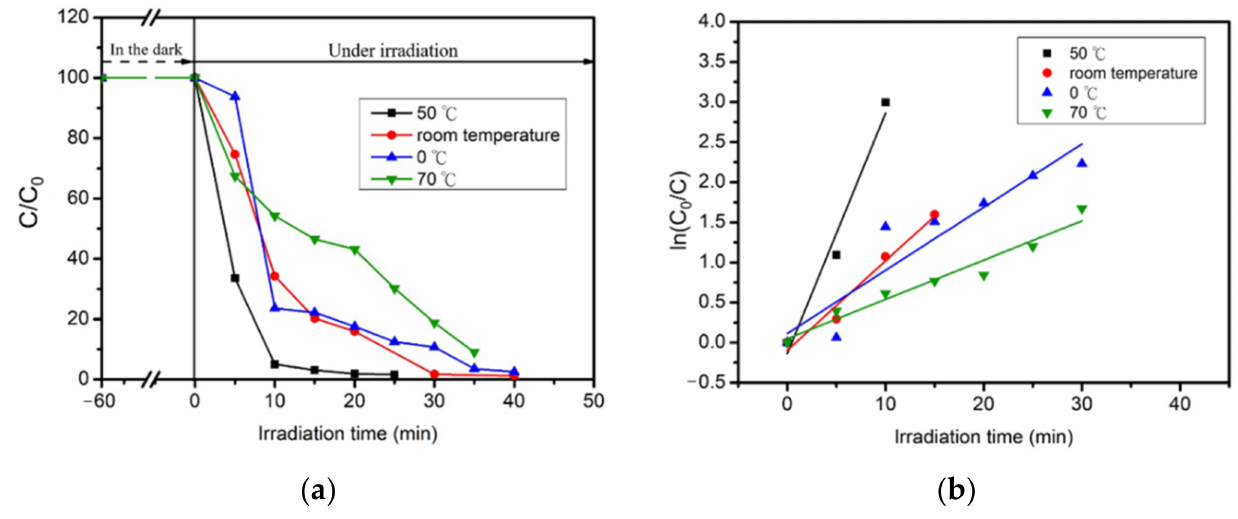
Figure 9. ( a ) Photodegradation of Pd/TiO 2 at different reaction temperatures; ( b ) Photocatalytic activities of Pd/TiO 2 at different reaction temperatures by plotting ln(C 0 /C) versus irradiation time